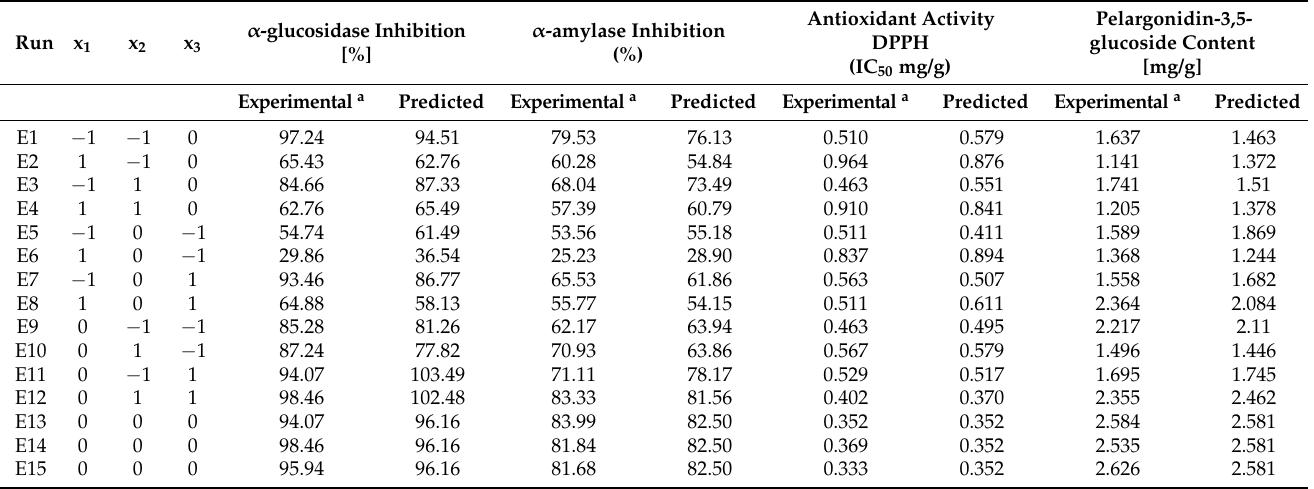
Table 2. The Box–Behnken design for the three independent variables. Experimental and predicted response for α -glucosidase and α -amylase inhibition, antioxidant activity (DPPH) and Pelargonidin- 3,5-glucoside content. a the average value of the results obtained.